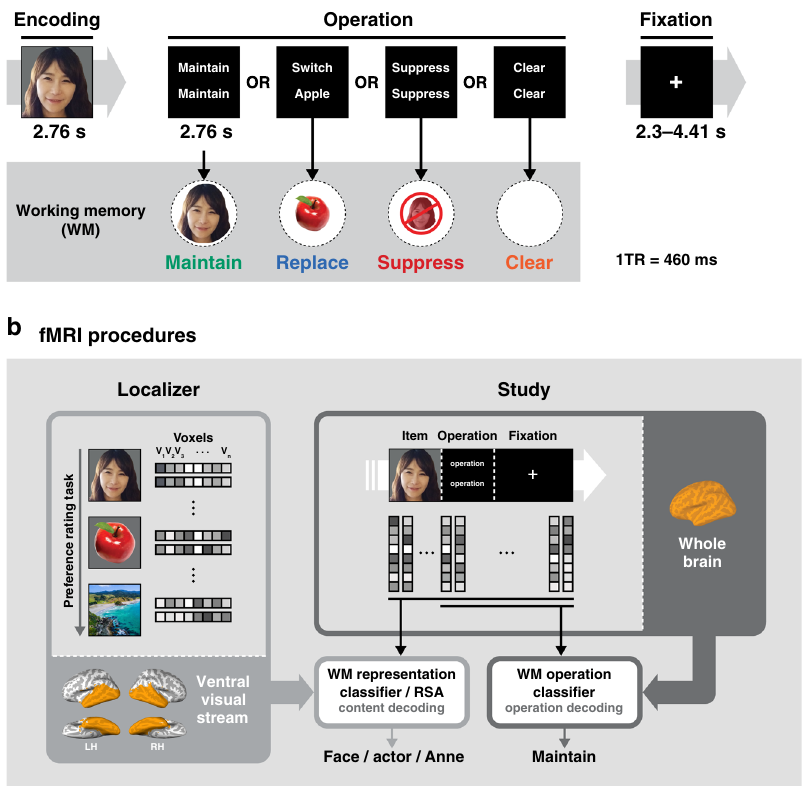
Fig. 1 Behavioral paradigm and fMRI procedures. a In the central study, on each trial, participants viewed a picture (a face, fruit, or scene) for 2.76 s. While images of famous faces (actors, musicians, and politicians) were used in the experiment, the authors ’ faces are featured in the fi gures instead. Next, a screen appeared for 2.76 s indicating which one of four different cognitive operations (maintain, replace, suppress, clear) should be applied to the just- viewed image. This screen was followed by a screen with a fi xation cross whose duration varied from 2.3 to 4.41 s. b Brain data from a perceptual localizer task (left) were used for multi-voxel pattern analysis (MVPA) for stimulus category-level and subcategory-level decoding, and item-level representational similarity analyses (RSA) of voxel activity in the ventral visual stream (VVS) ROI. These analyses were then applied to brain data from the central study to enable decoding of information within the focus of attention in working memory (WM). Note that whole brain data was used for the subcategory classi fi er to capture semantic differences across subcategories (e.g., actors vs. musicians). Additionally, whole brain data from the central study was used for pattern classi fi cation of the cognitive operation being performed on each